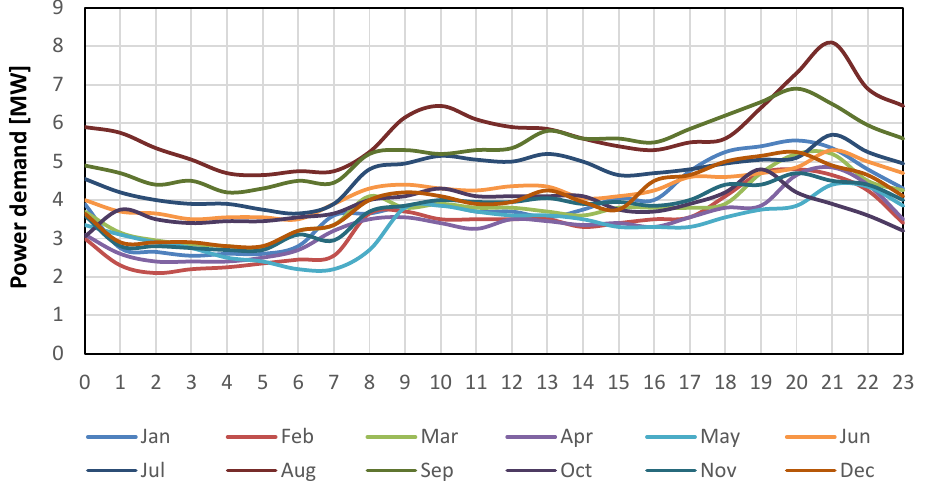
Figure A4. Hourly electricity demand in monthly typical days in 2016 [80].